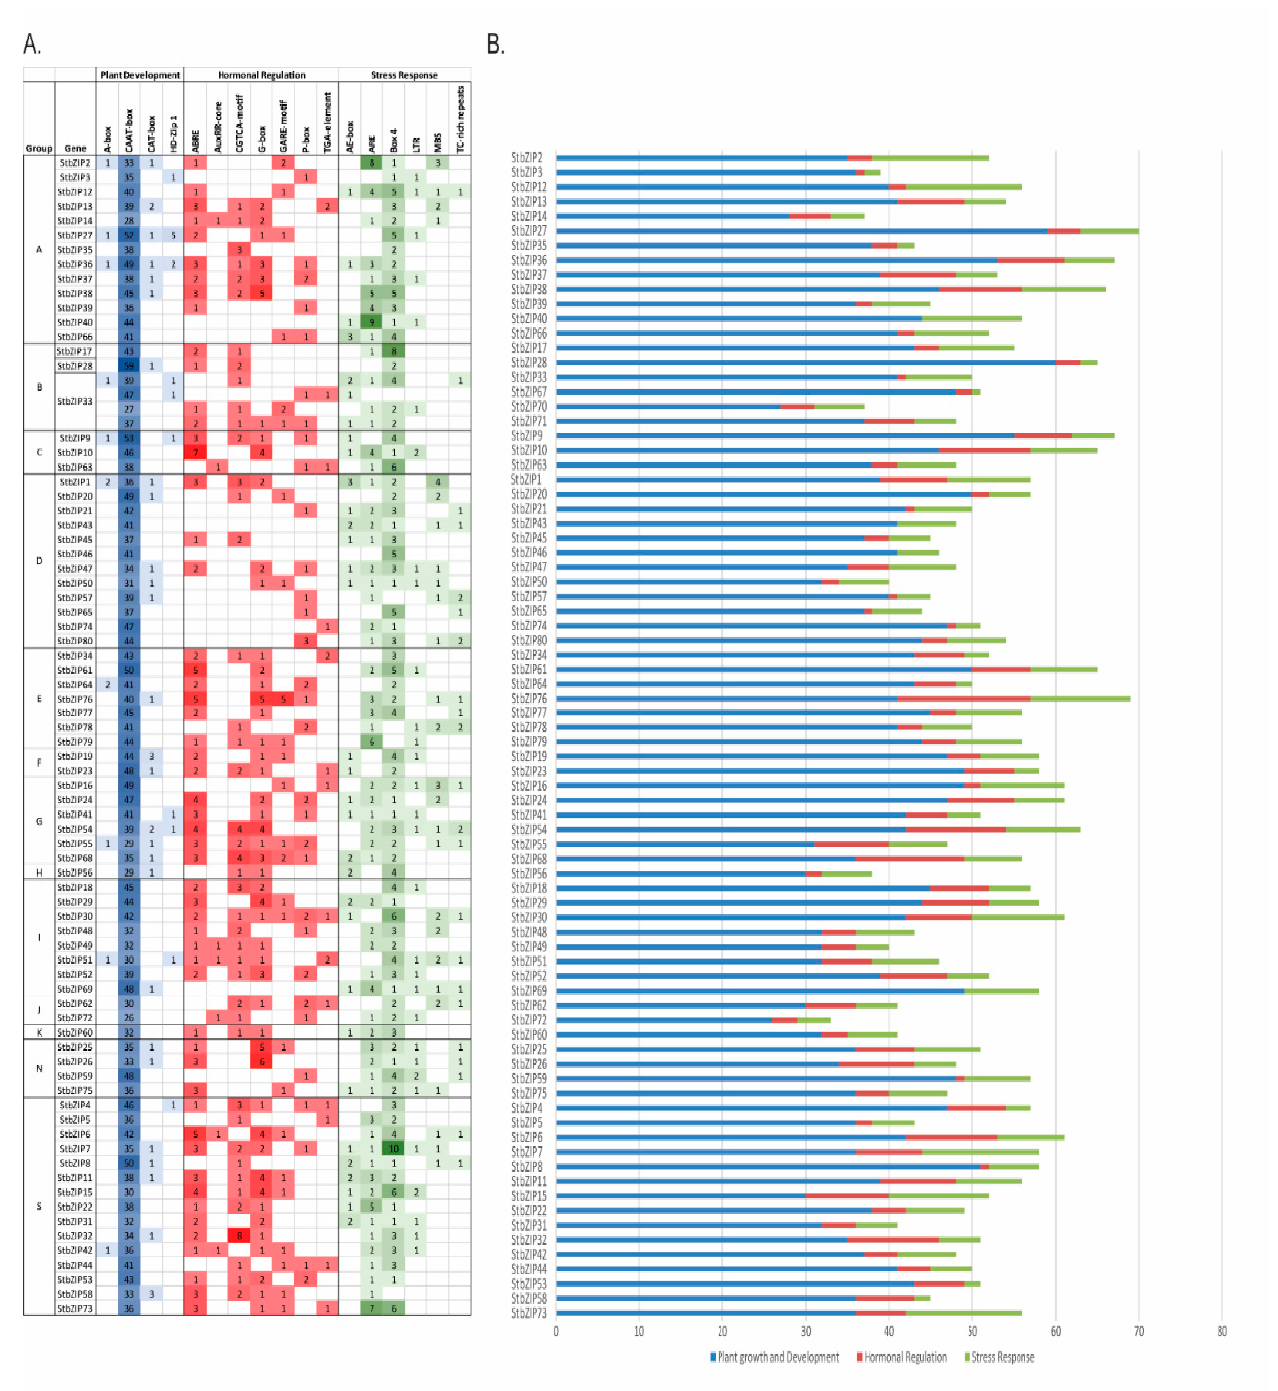
Figure 6. Distribution and frequency of cis-regulatory elements (CREs) on StbZIP promoters. Promoter sequences representing 2000 bp from the transcription start site of StbZIP genes were extracted from the DM1-3 516 R44 v 6.1 assembly at Spud DB as described in Materials and Methods Section 3.4. ( A ) The grid provides the number of sites that contain the CREs involved in the development, hormone signaling, and stress responses. Shades of green, red, and blue point to CREs that are highly represented (dark-colored), moderately represented (medium colored), once or twice represented (light color), or not present (white color). ( B ) Bar graph demonstrates the distribution frequency of CREs involved in the development, hormone signaling, and stress responses across the 2000 bp sequences analyzed for each StbZIP .